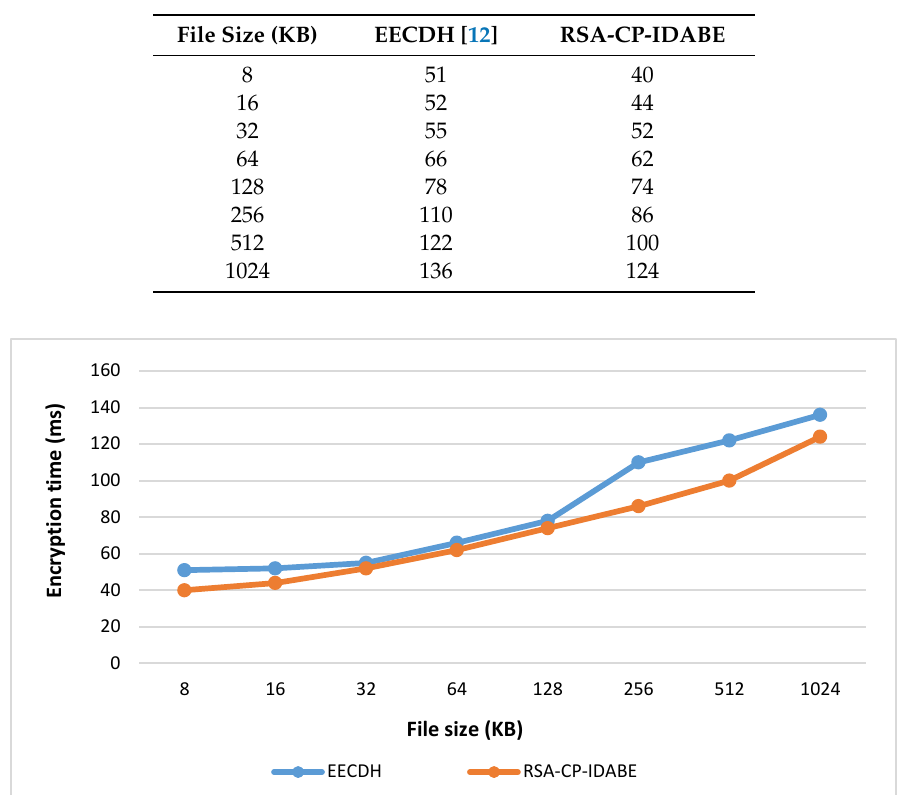
Table 2. Encryption time vs. file size for RSA-CP-IDABE & EECDH.